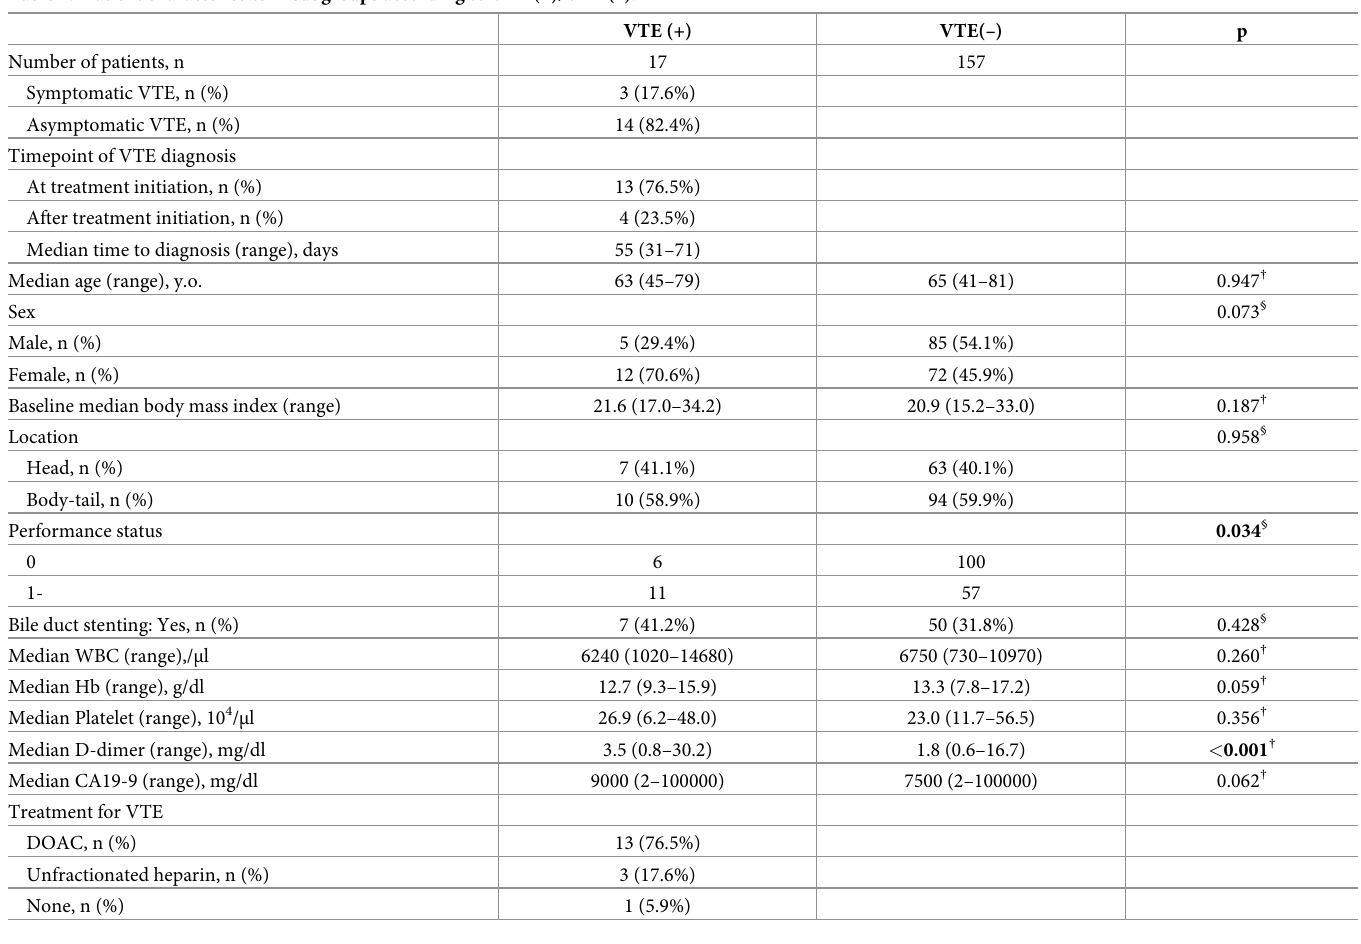
Table 1. Patient characteristics in subgroups according to VTE (+)/VTE